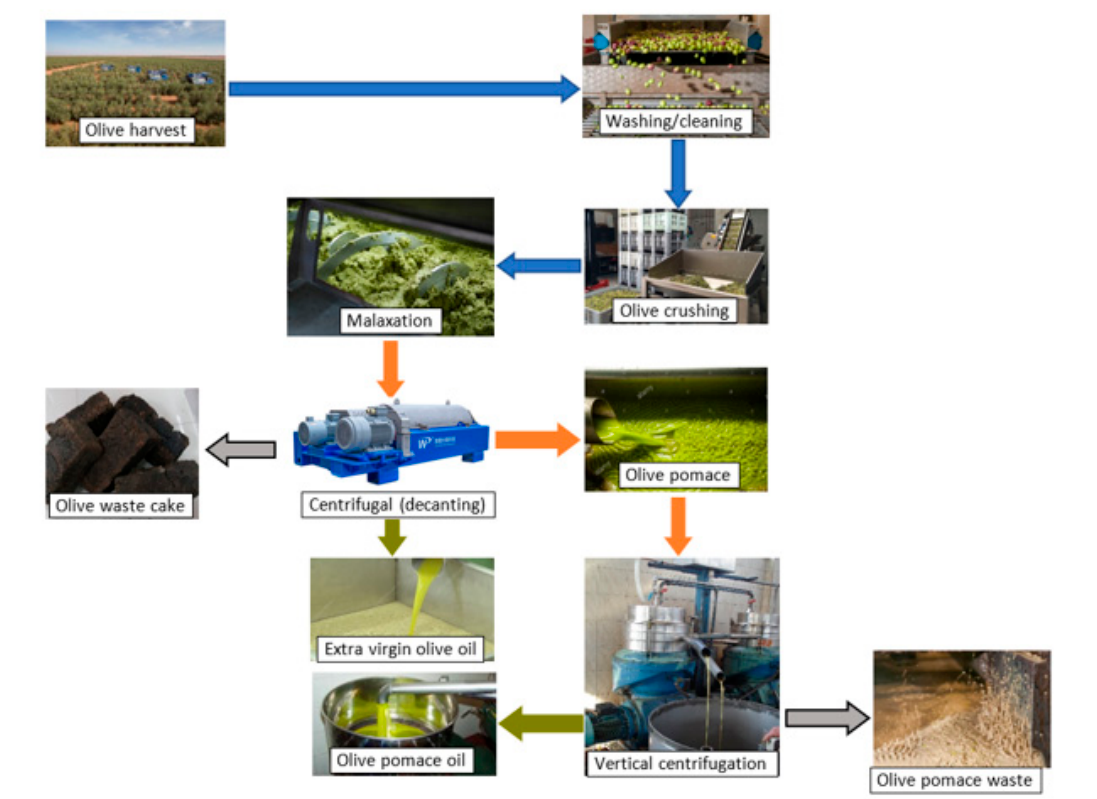
Figure 1. A flow process diagram of olive pomace waste generation.